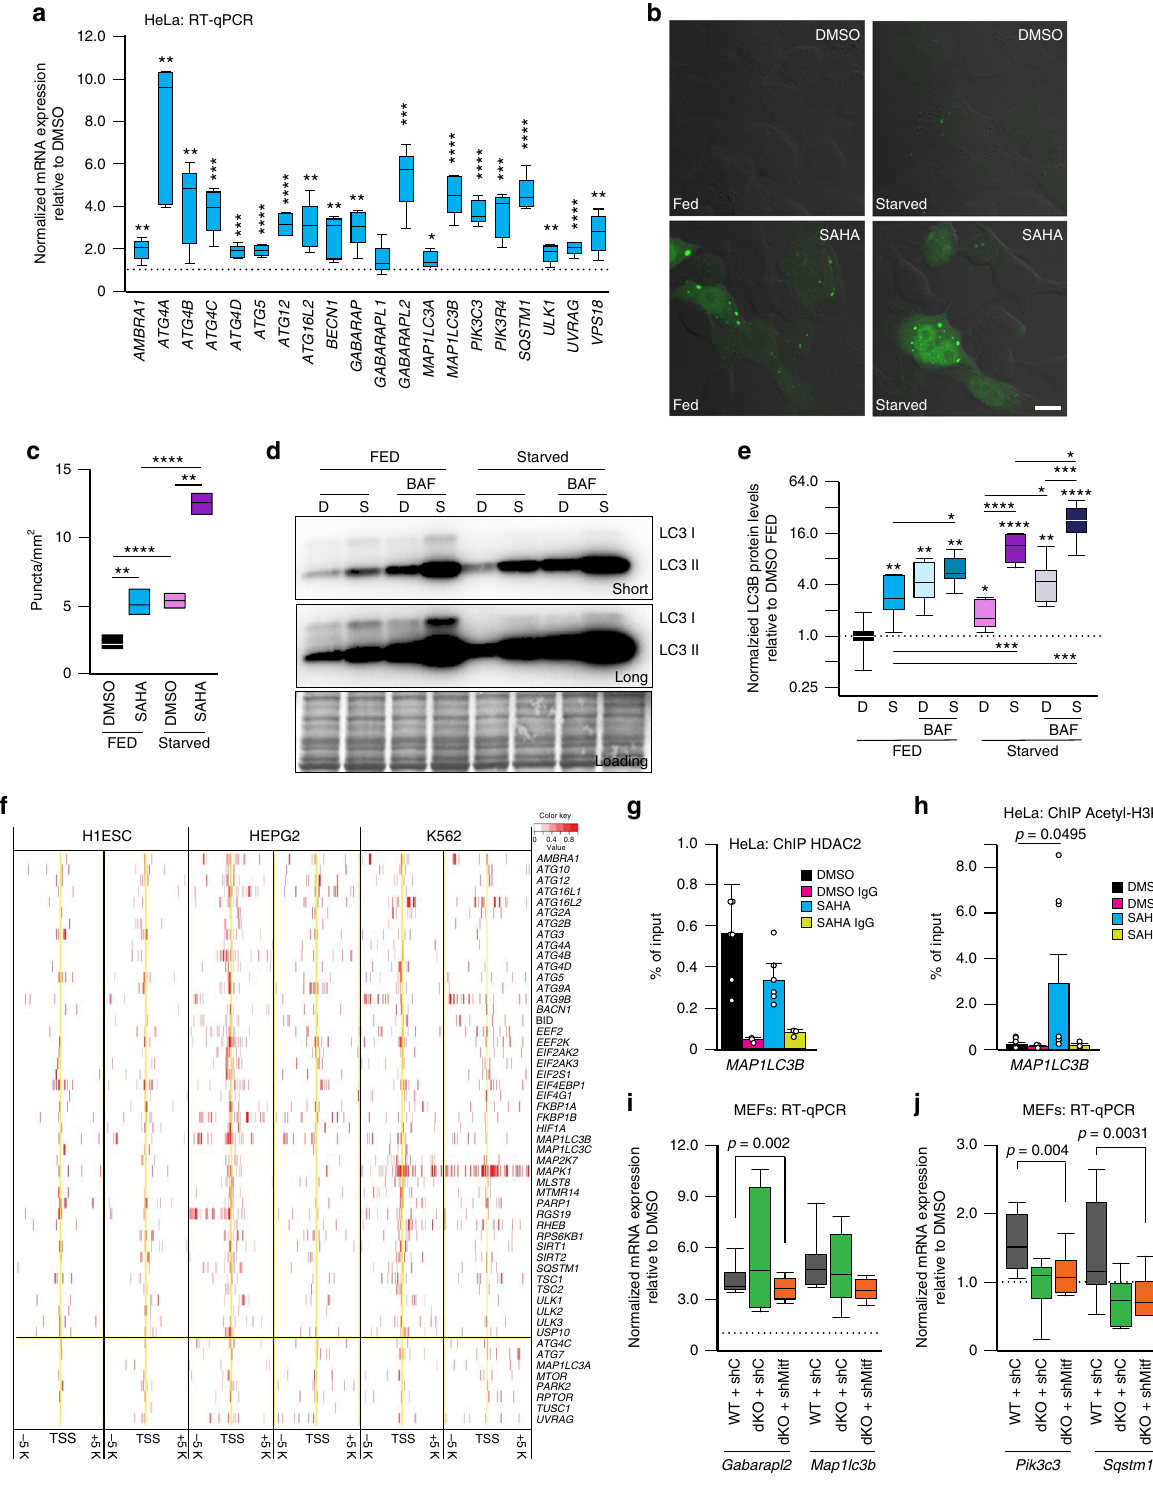
enzyme in all treated fi broblasts, which was paralleled by enhanced NEU1 residual enzyme activity (Fig. 8b, c and Sup- plementary Fig. 7). ChIP performed with acetylated H3K14 antibody showed acetylation of the NEU1 promoter region also in sialidosis fi broblasts, con fi rming NEU1 tran- scriptional activation (Fig. 8d). These fi ndings potentially broaden the use of HDAC inhibitors for ameliorating the dis- ease phenotype in some forms of